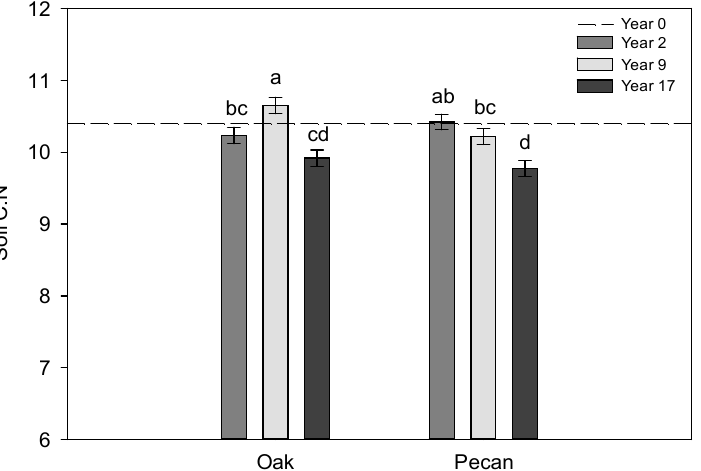
Figure 1. Soil C:N over time in a 17-year agroforestry site in Fayetteville, AR, per tree species, and averaged across fertilization treatments. Dashed lines represent baseline values (1999). Means followed by the same letter do not differ at p < 0.05.